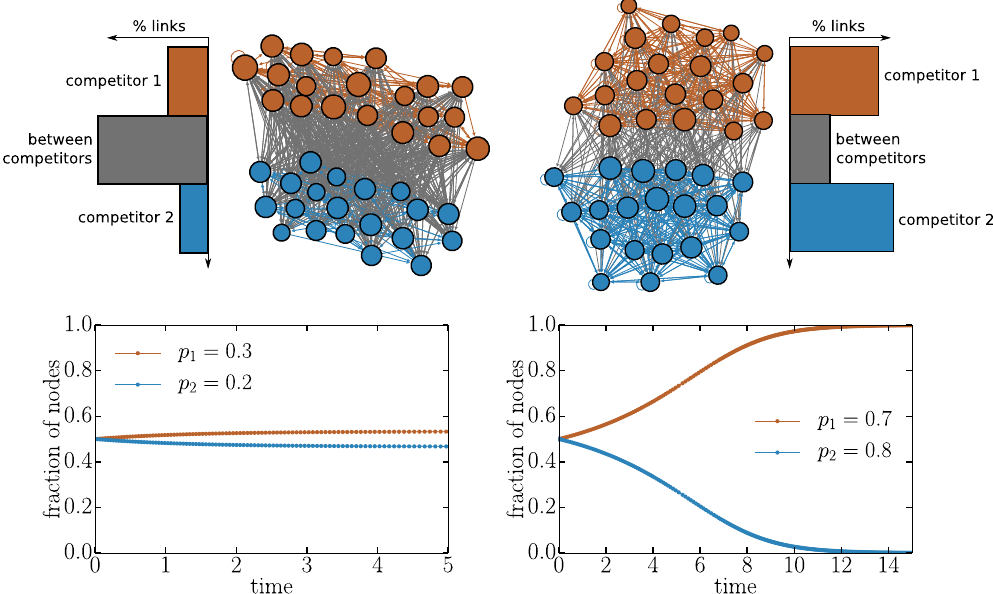
Figure 2. Examples of a two competitor contest with assortative and disassortative strategies. We illustrate topologies given two set of strategies. Node color corresponds to its current state, node size is proportional to its total degree, and links are colored according to the states of the nodes they connect. (left) A disassortative structure: nodes tend to connect to nodes of a different state, notice that most links are grey which denotes inter block links. (right) An assortative structure: nodes tend to connect to nodes of the same state. (bottom) Time evolution of the voter model on these adaptive topologies. In the disassortative structure both competitors can coexist whereas the assortative structure leads to a winner-takes-all